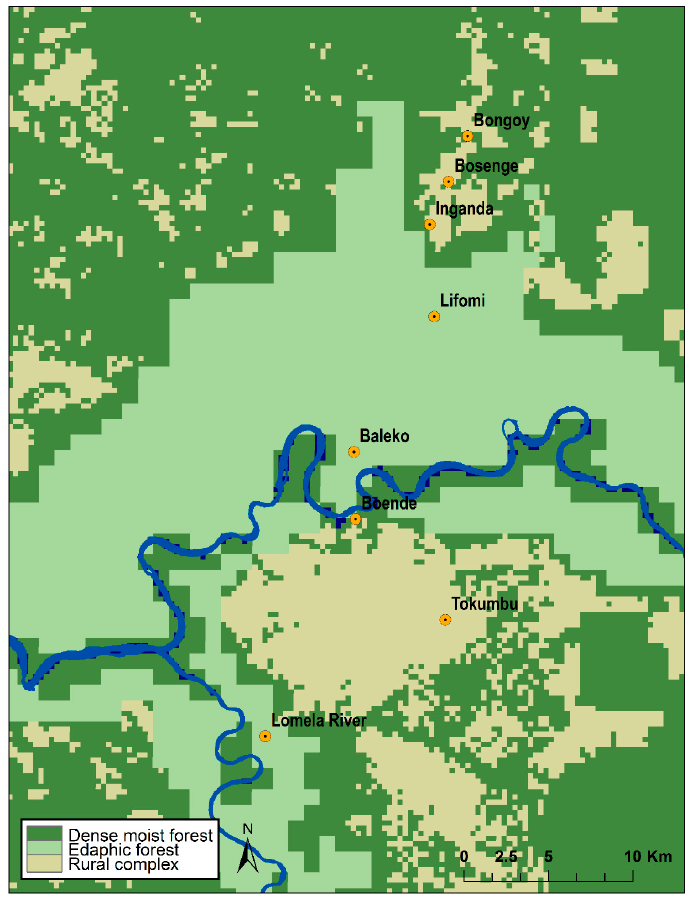
Figure 2. Vegetation types for our study area based on Verhegghen et al. (2012) [36].